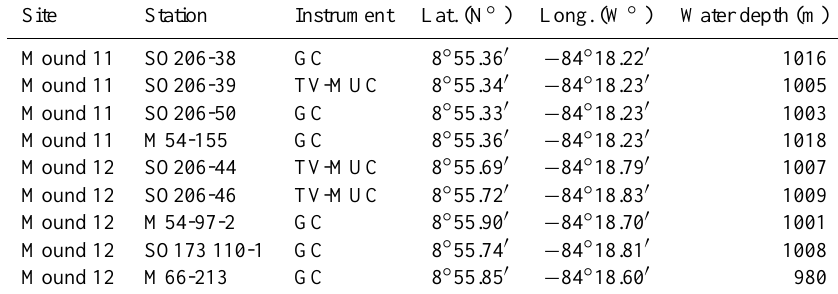
Table 1. Overview of sampled stations at Mound 11 and 12 during cruises SO206, SO173/4, M66/3a, and M54/3a.